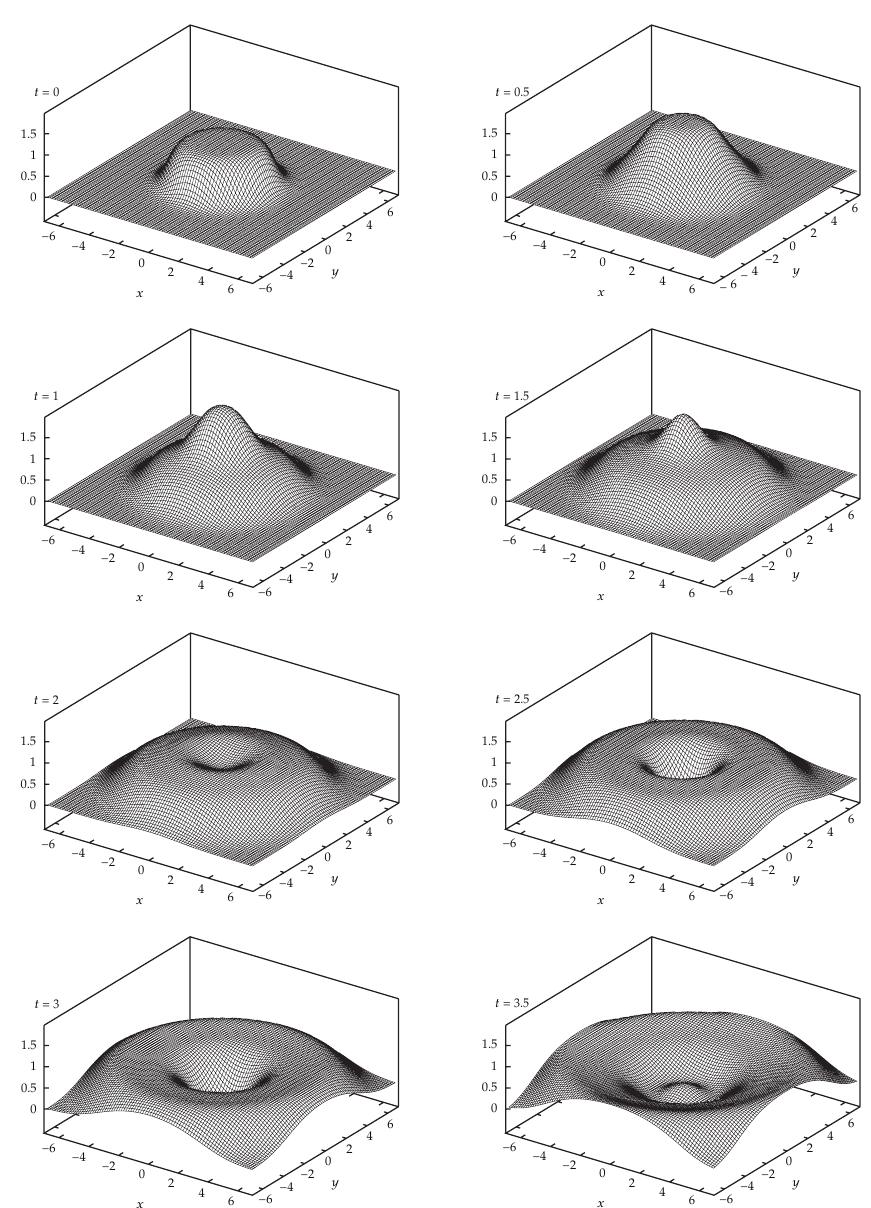
Figure 5: Numerical solution to (cid:4) 1.1 (cid:5) for α (cid:2) 1 . 5, t ∈ (cid:6) 0 , 3 . 5 (cid:7) , k (cid:4) t (cid:5) (cid:2) cos (cid:4) t (cid:5) , b (cid:4) t (cid:5) (cid:2) e − t . Periodic boundary